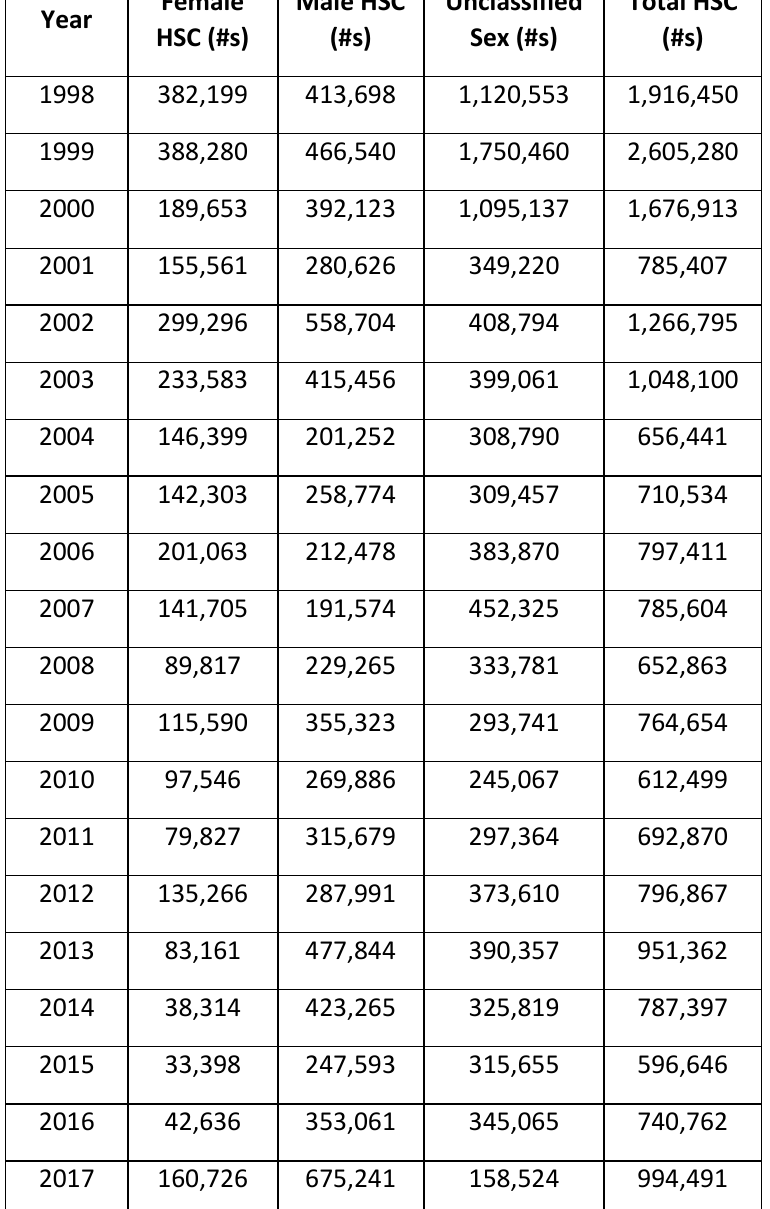
Coastwide horseshoe crab (HSC) commercial bait landings in numbers, 1998- 2016, as validated by ACCSP. The 2017 landings are from state compliance